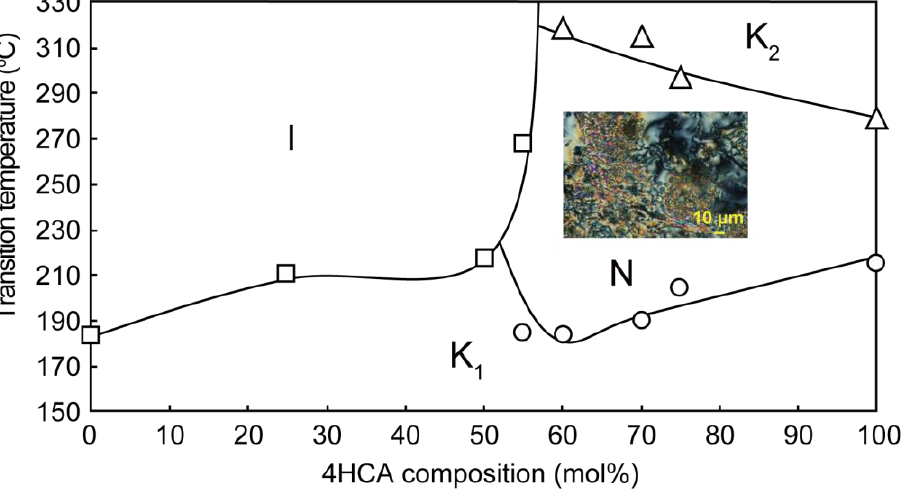
Figure 3. Phase diagram of Poly(3,4-BAHBA- co -4HCA)s of various compositions. The inset picture is a crossed-polarizing photomicrograph of Poly(3,4-BAHBA- co -4HCA) with a 4HCA composition of 60 mol% at 256